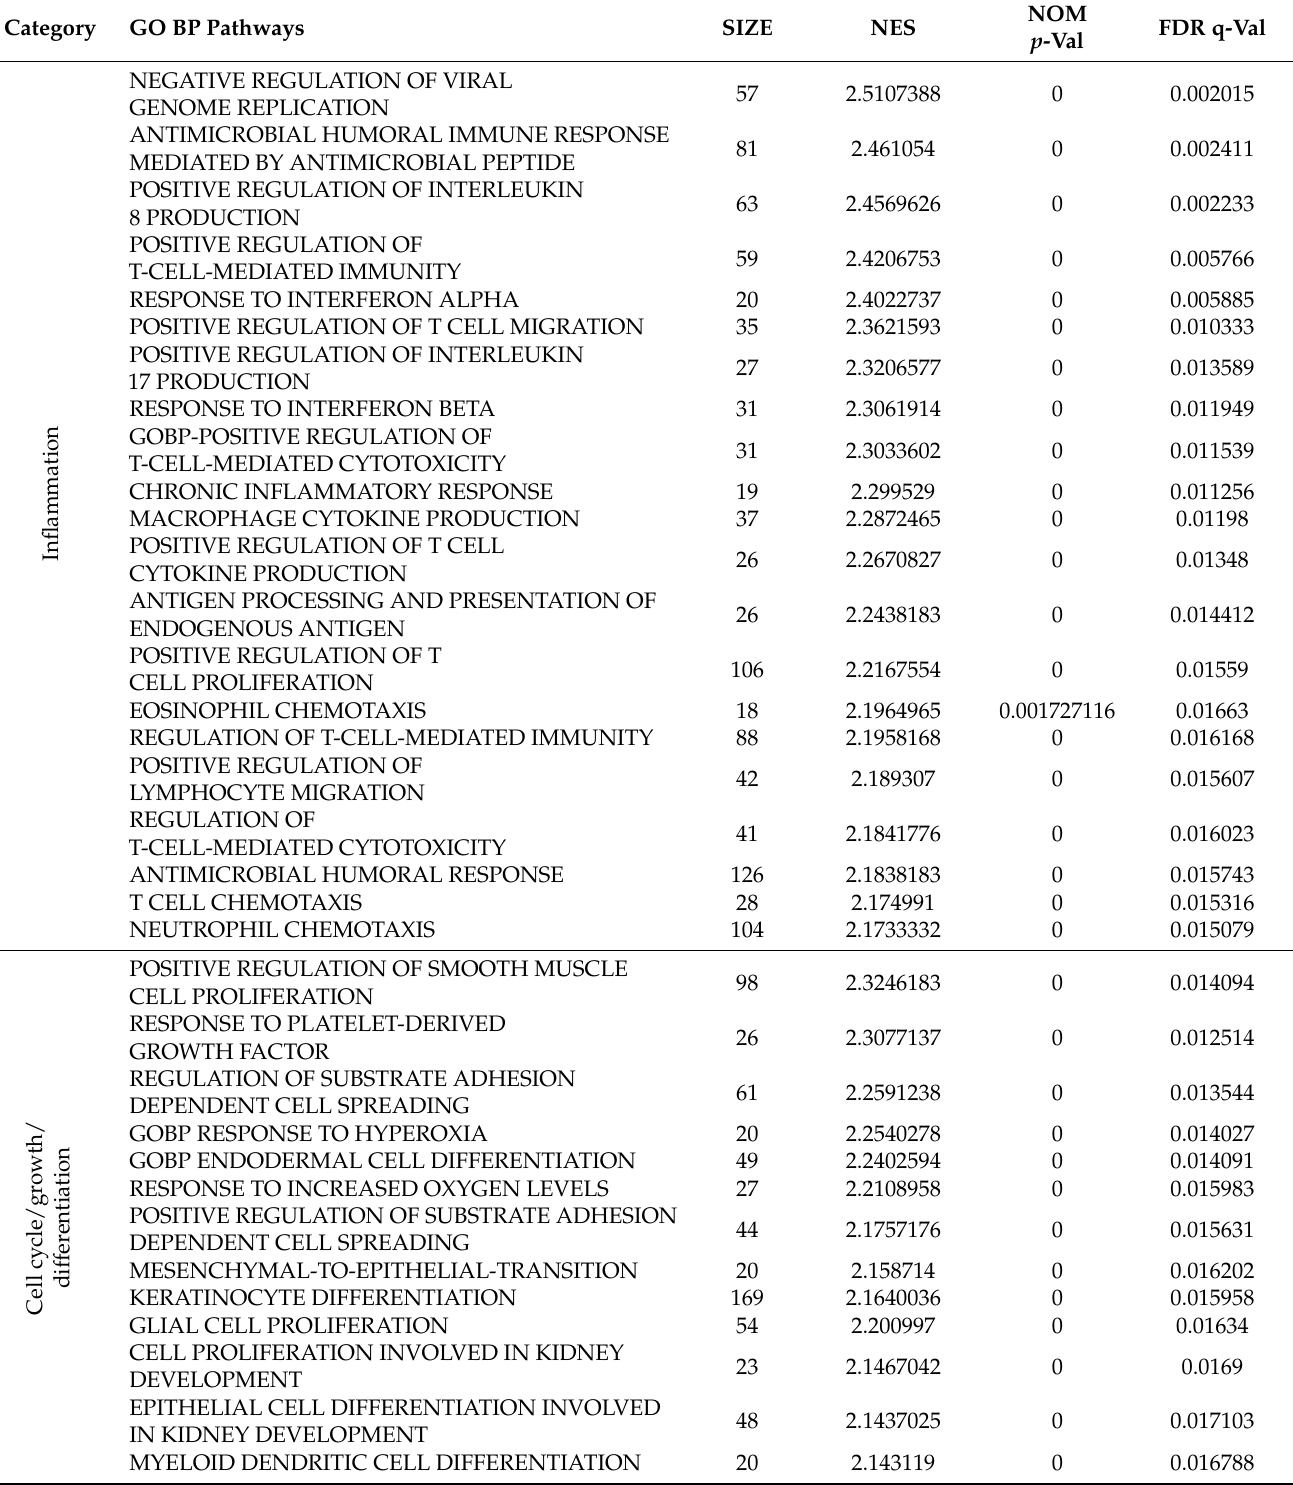
Table 1. GO pathways identified gene set enrichment analysis. RNAseq data were compared between P0 and P2 HBECs using GSEA_4.3.2 and ranked based on normalized enrichment score (NES). FDR, false discovery